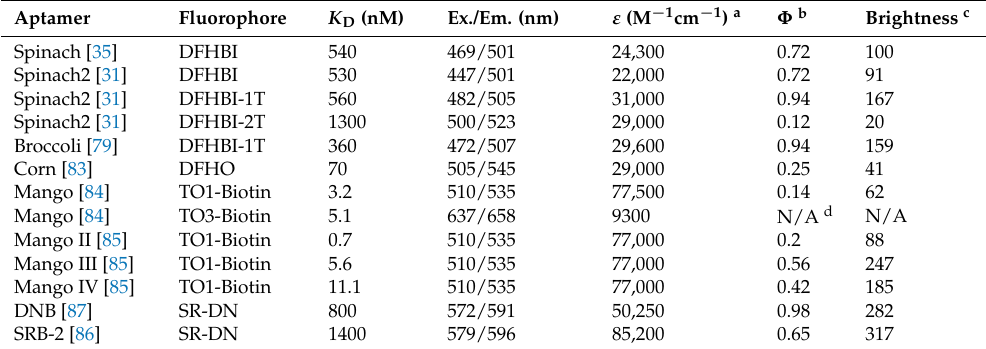
Table 1. Commonly used fluorogenic RNA complexes and their spectral